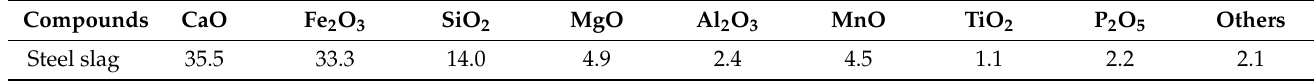
Table 2. Chemical composition of